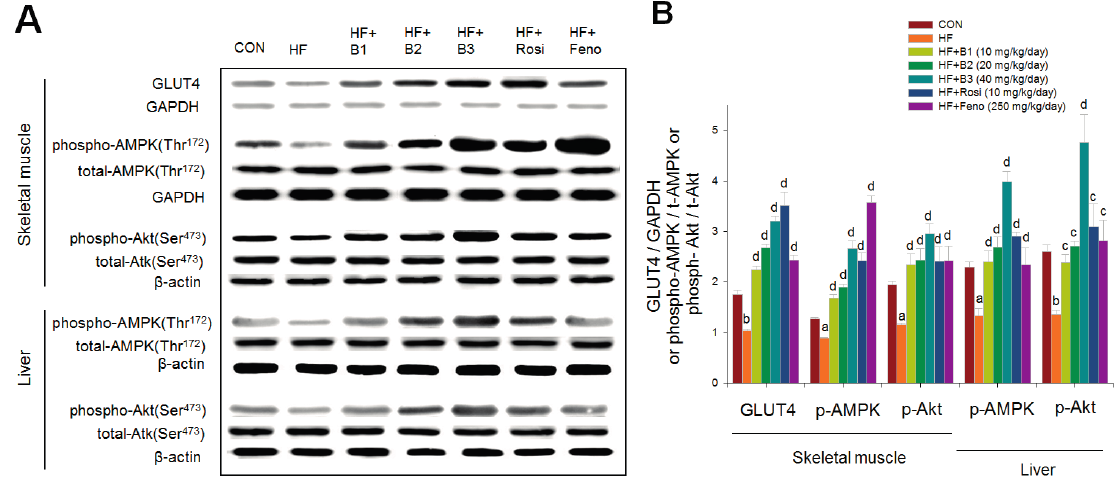
Figure 6. The protein contents of GLUT4 in skeletal muscle, and the expression levels of phospho-AMPK (Thr 172 )/total AMPK and phospho-Akt/total Akt in skeletal muscle and liver tissue of the mice receiving ( − )-epicatechin-3- O - β - D -allopyranoside (BB) by oral gavage for four weeks. Protein was separated by 12% SDS-PAGE detected by Western blot. ( A ) Representative image; ( B ) Mean ± SE, GLUT4/GAPDH or phospho-AMPK/t-AMPK or Phospho-Akt/t-Akt expression levels. All values are means ± SE ( n = 9). a p < 0.05, and b p < 0.001 compared with the low-fat diet (CON) group; c p < 0.05, and d p <